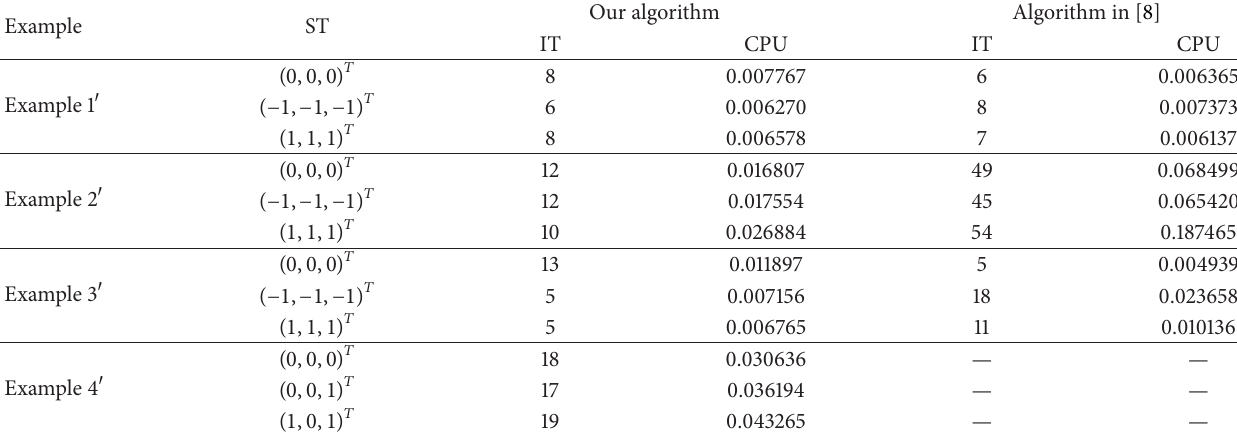
Table 5: Numerical results for Examples 1 󸀠 –4 󸀠